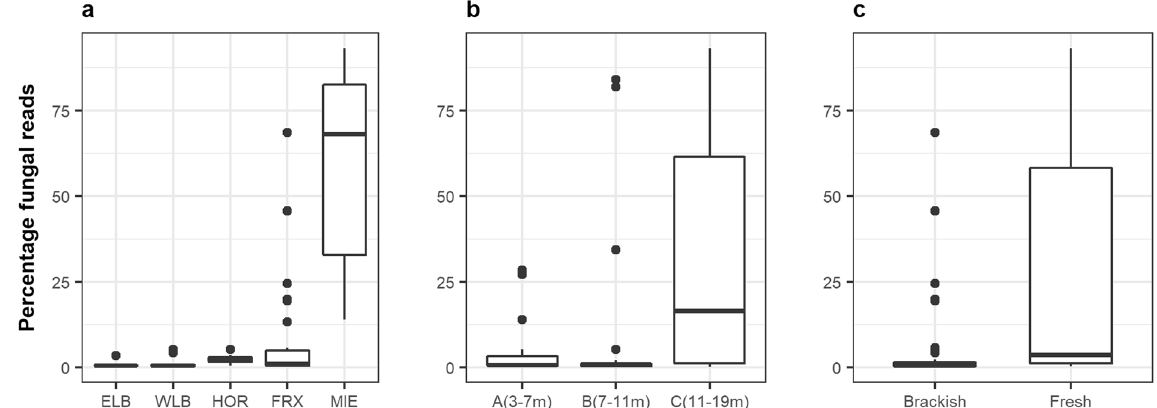
Figure 3. Percentage of sequences assigned to fungal taxa compared to the total number of eukaryotic sequences, estimated for each lake ( a ), depth layer ( b ) and aquatic habitat ( c ). ELB: Lake Bonney East lobe (n = 5), WLB: Lake Bonney West lobe (n = 19), FRX: Lake Fryxell (n = 27), HOR: Lake Hoare (n = 7), MIE: Lake Miers (n = 12).